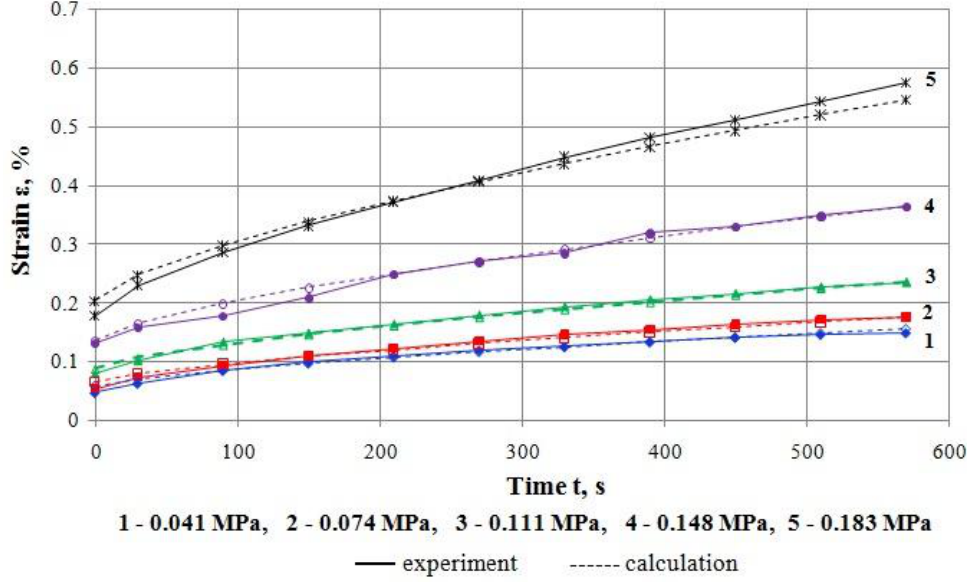
Figure 11. Experimental and calculated creep curves of the asphalt concrete at various stresses.